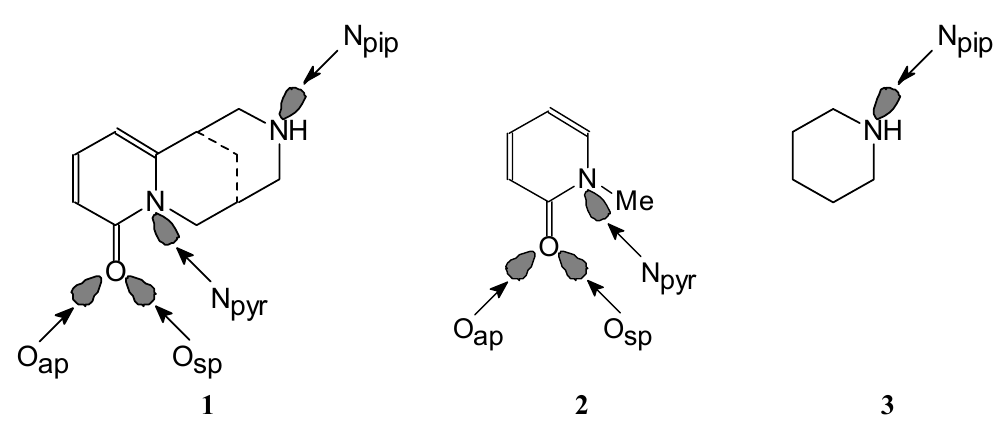
Figure 2. Possible sites of protonation in cytisine ( 1 ) and its model compounds: N -methyl-2-pyridone ( 2 ) and piperidine ( 3 ).